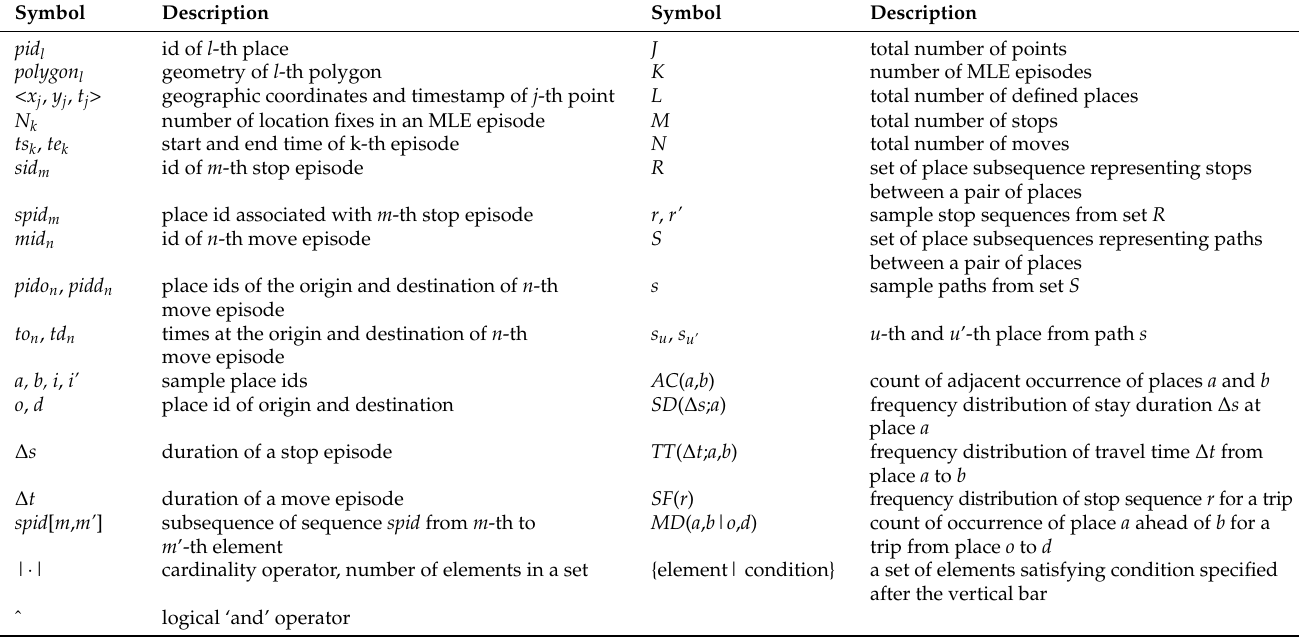
Table 1. List of